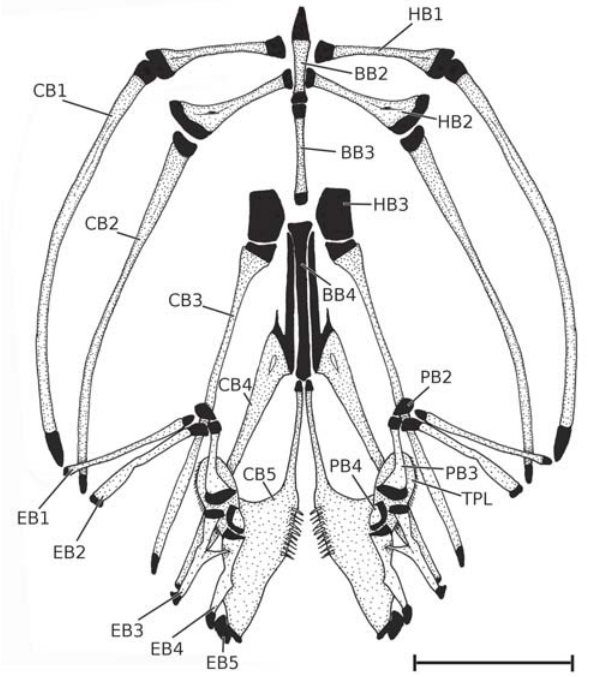
Fig. 10. Branchial skeleton of Leptodoras oyakawai , based on MZUSP 95722, 73 mm SL, in dorsal view. BB2-4 basibranchials, CB1-5 ceratobranchials, EB1-5 epibranchials, HB1-3 hypobranchials, PB2-4 pharingobranchials, TPL tooth plate. Scale bar 5